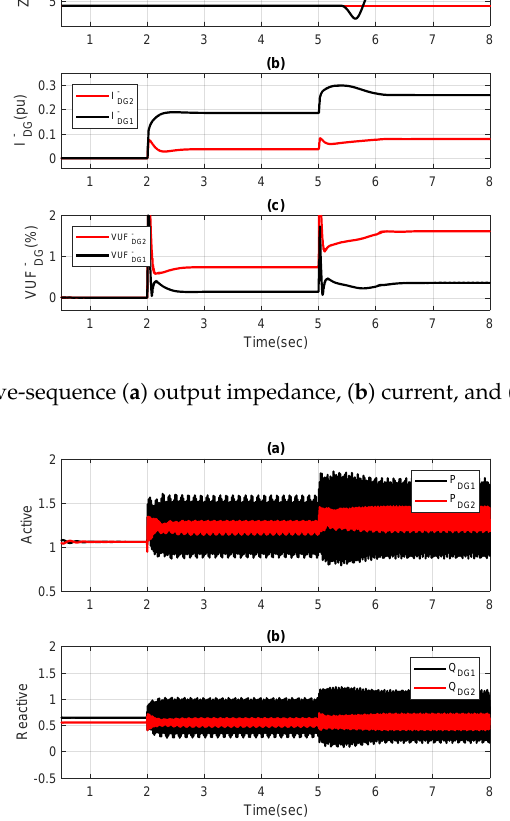
Figure 13. Dynamic response of DG units to unbalanced load changes in feeder F 1 : ( a ) real power, and ( b ) reactive power components of DG